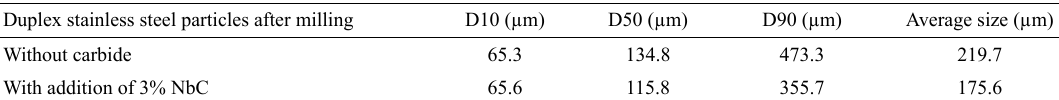
Table 1. Duplex stainless steel powders “D” values.